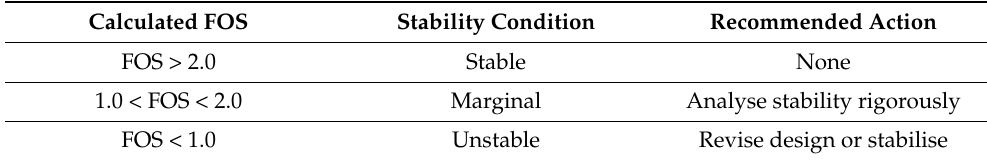
Table 1. Stability condition analysis for wedge failure (Adapted from